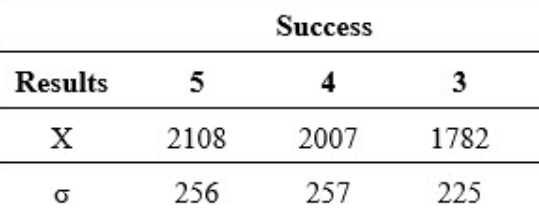
Table 6. Results (X and σ) by the suc